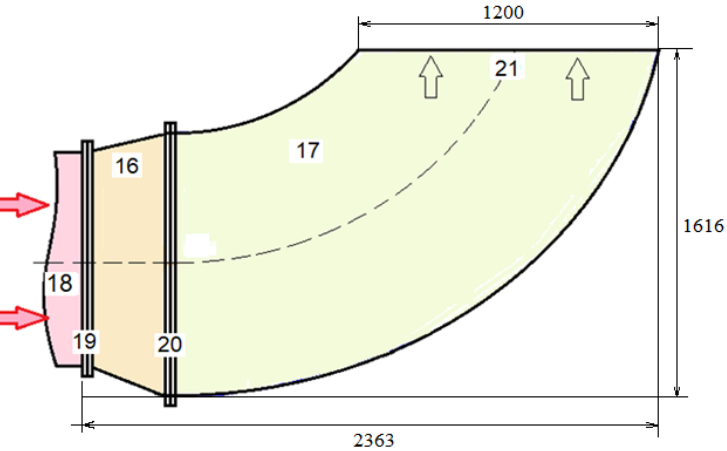
Figure 2. Device for turning the jet stream to the zenith: 16 —the cone-shaped diffuser; 17 —the 70° bend; 18 —engine nozzle outlet; 19 and 20 —connecting flanges; 21 —outlet of the bend, cut in horizontal plane.